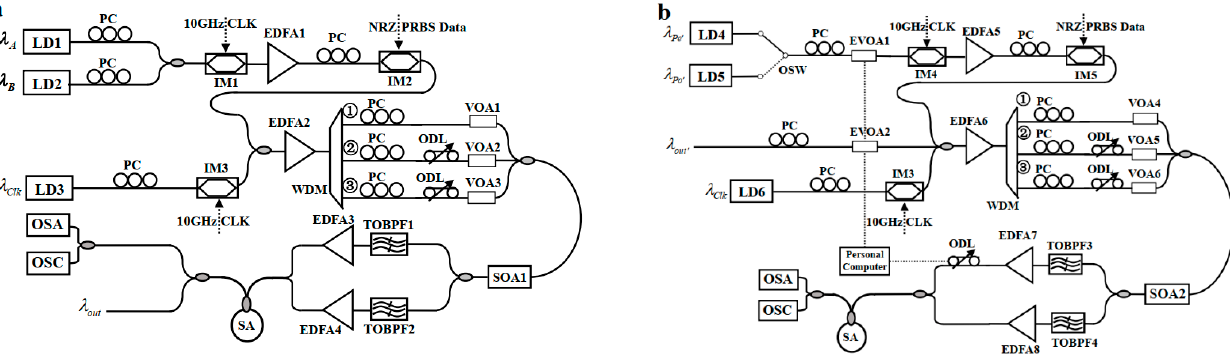
Figure 2. The experimental setup of all ‐ optical non ‐ inverted parity generator ( a ) and checker ( b ) (PC polarization controller, EVOA electrical variable optical attenuator, IM intensity modulator, CLK electronic clock, ODL optical delay line, VOA variable optical attenuator, TOBPF tunable optical band pass filter, WDM wavelength division multiplexer, SMF single ‐ mode fiber, EDFA erbium ‐ doped fiber amplifier, OSW optical switch, SA saturable absorber).